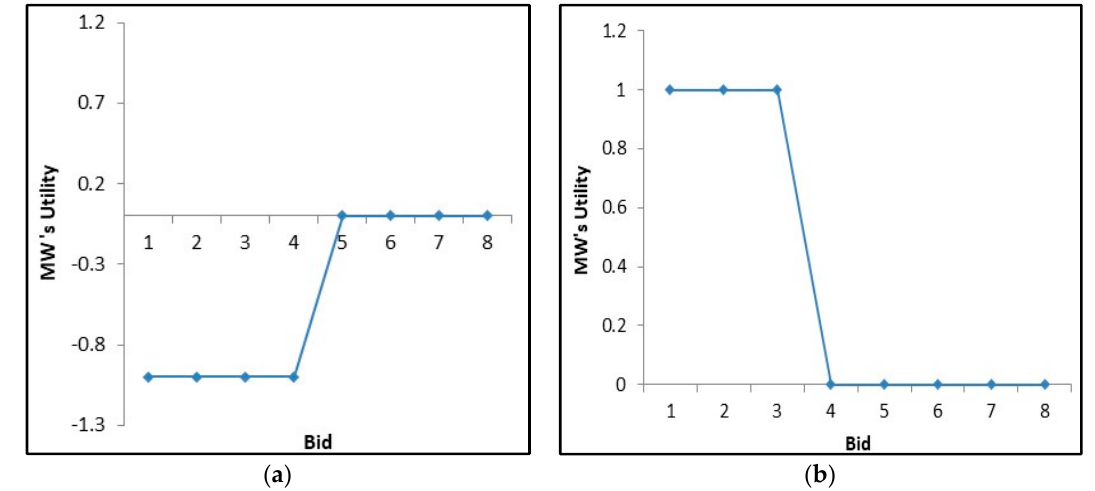
Figure 6. Cost truthfulness for ( a ) T-drive dataset and ( b ) Gowalla dataset.